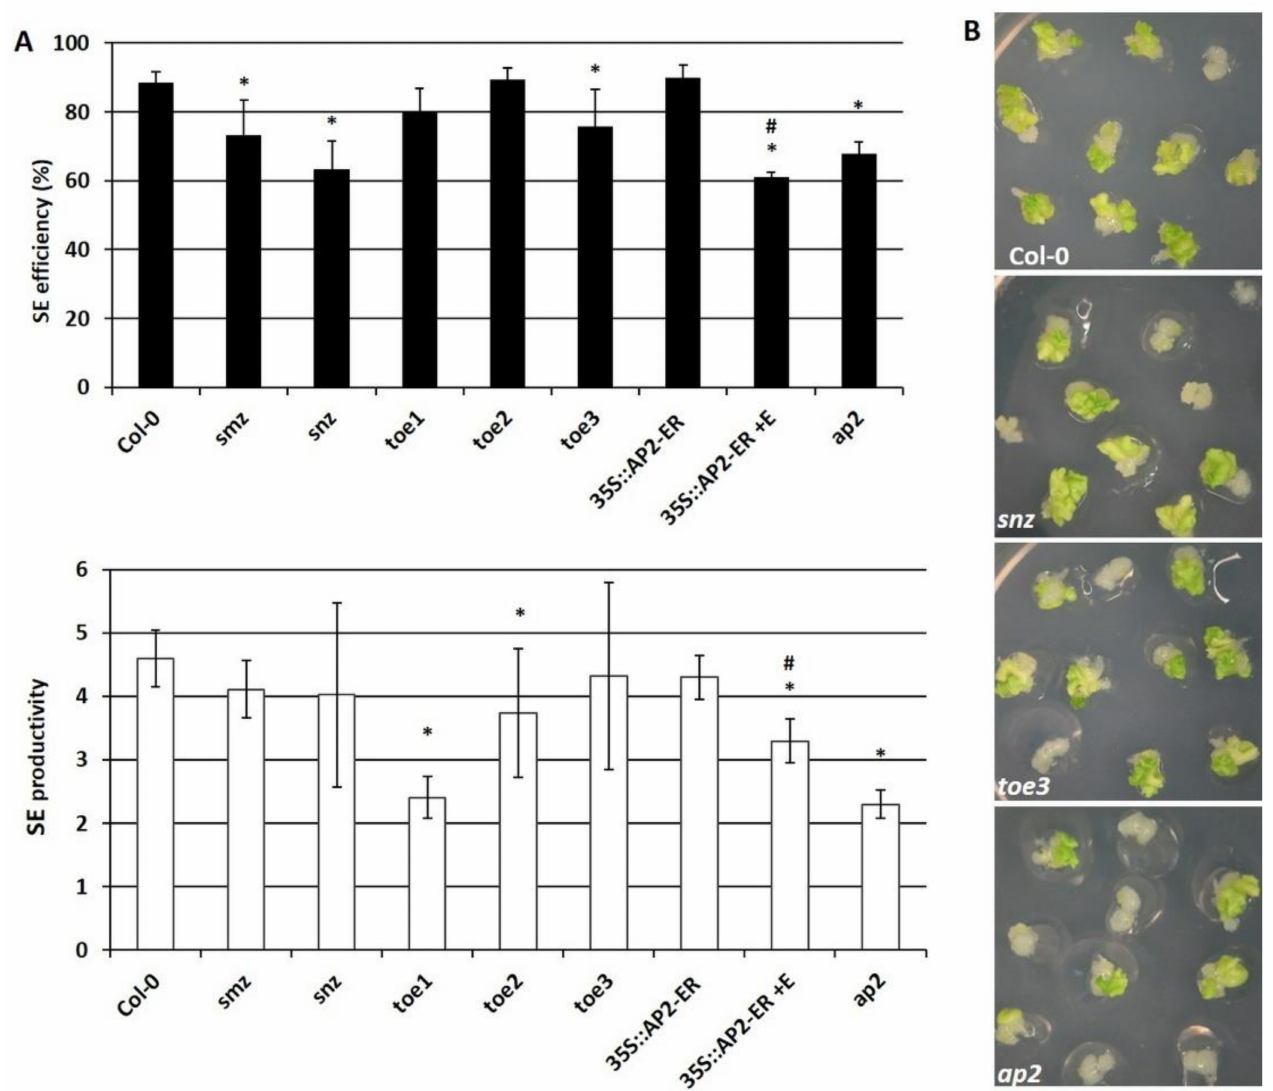
Figure 3. The impaired embryogenic response in the cultures affected the candidate miR172 target genes, including the smz , snz , toe1 , toe2 , toe3 and ap2 mutants and the AP2 -induced overexpression line, 35S:: AP2 -ER, compared to the WT culture, Col-0. The significantly impaired SE efficiency and productivity ( A ) of the analyzed genotypes were exemplified by the reduced embryogenic response of the representative mutants snz , toe3 , ap2 ( B ). The explants were induced on an auxin (E5) medium and the embryogenic response was evaluated in 21-day-old cultures. The AP2 overexpression was induced with β -estradiol (+E). * values significantly different from the WT, Col-0 ( p < 0.05; n = 3 ± SD); #—values significantly different from the 35S:: AP2 -ER -E culture ( p < 0.05; n = 3 ±